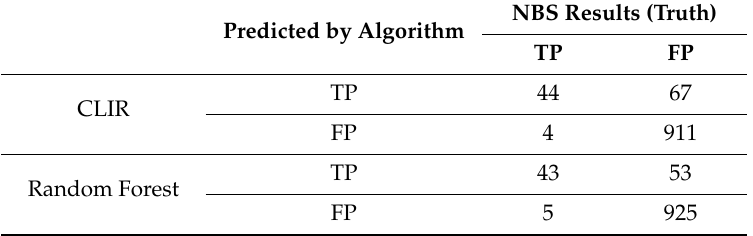
Table 4. Comparison of CLIR and Random Forest for GA-1 screen positives (cleaned data) (true positive (TP) and false positive (FP)).